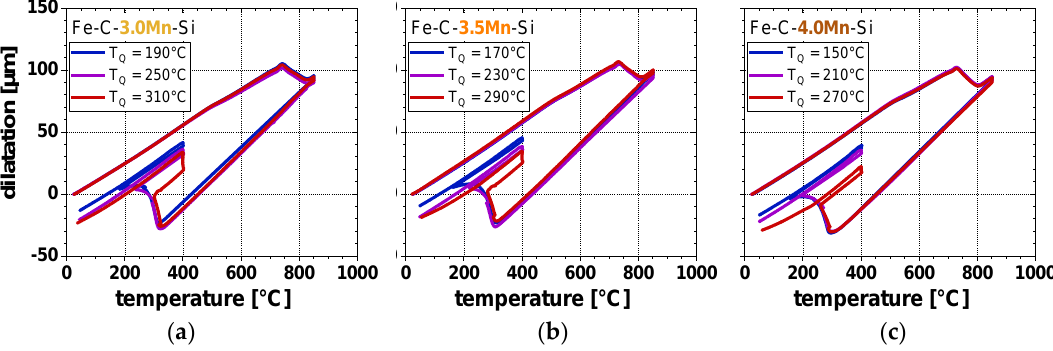
Figure 2. Dilatometric curves for the ( a ) Fe-C-3.0Mn-Si, ( b ) Fe-C-3.5Mn-Si, and ( c ) Fe-C-4.0Mn-Si steels quenched to different T Q in order to adjust 50 vol.% (red), 75 vol.% (purple) and 85 vol.% (blue) α’ prim .